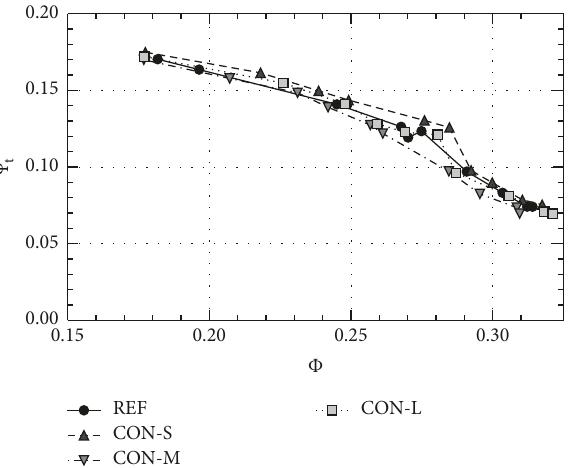
Figure 15: Influence of conical shroud extensions ( 𝜇 = 0 ).